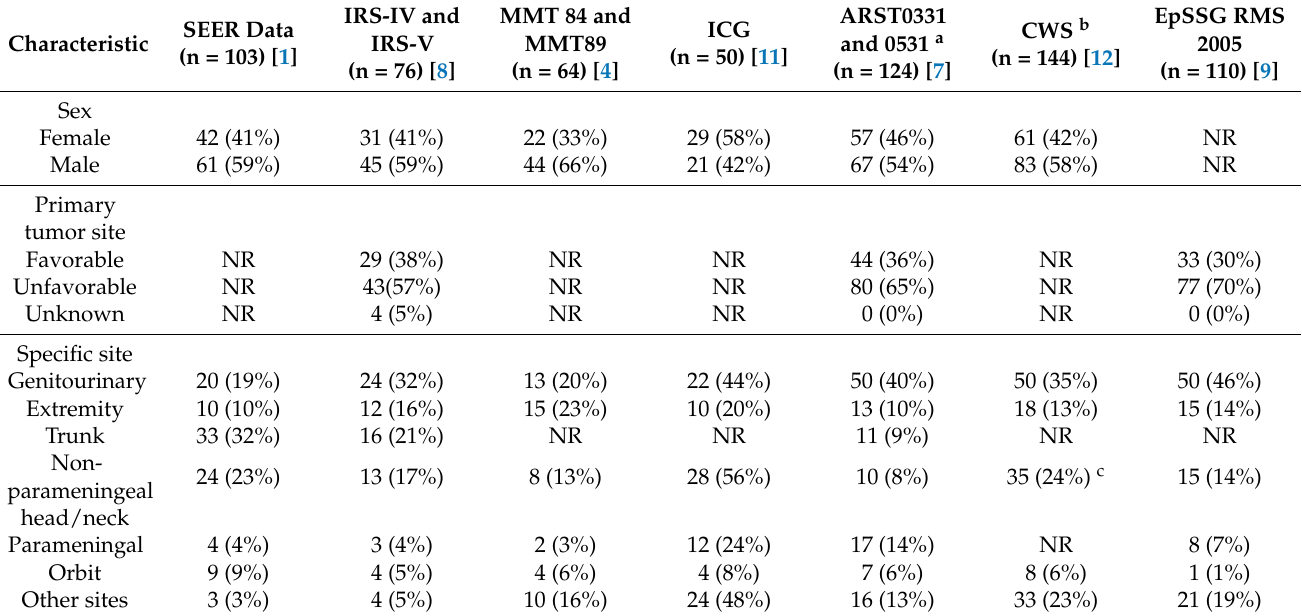
Table 1. Clinical characteristics of infants with